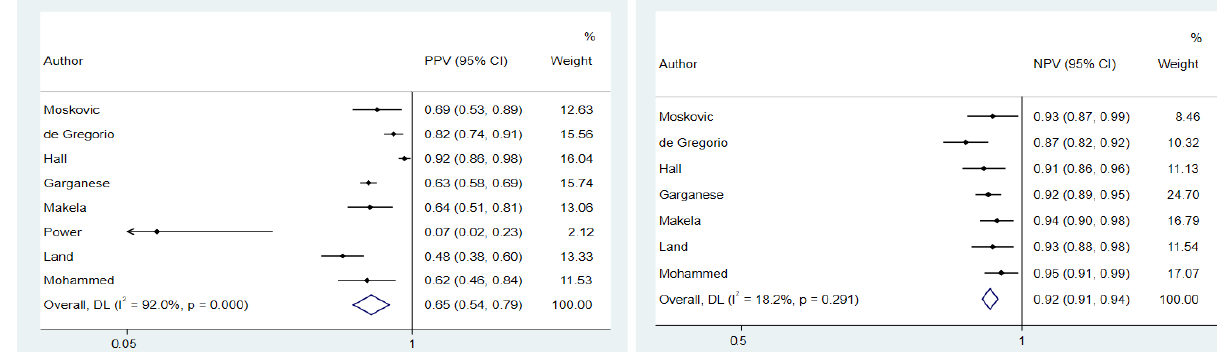
Figure 3. Forest plot for positive predictive value and negative predictive value.